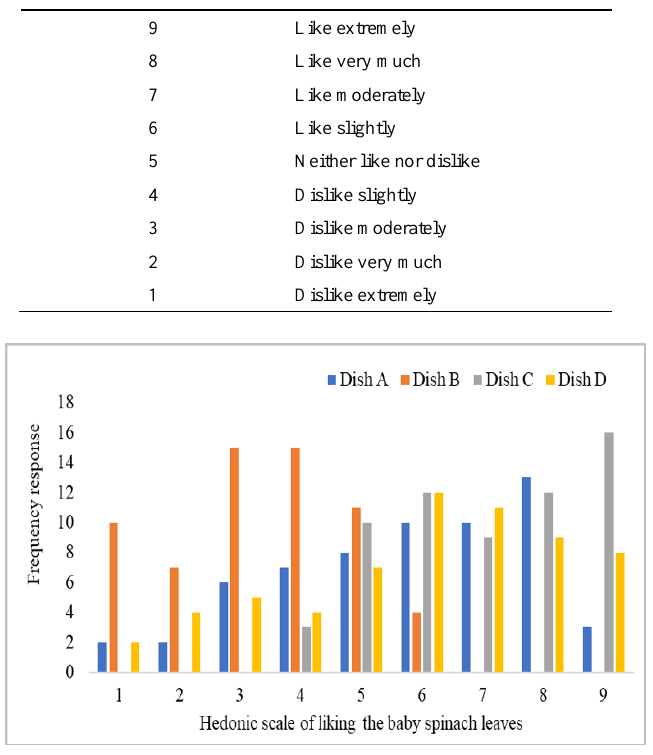
Table 2 . Hedonic scale showing the overall degree of liking of vegetable